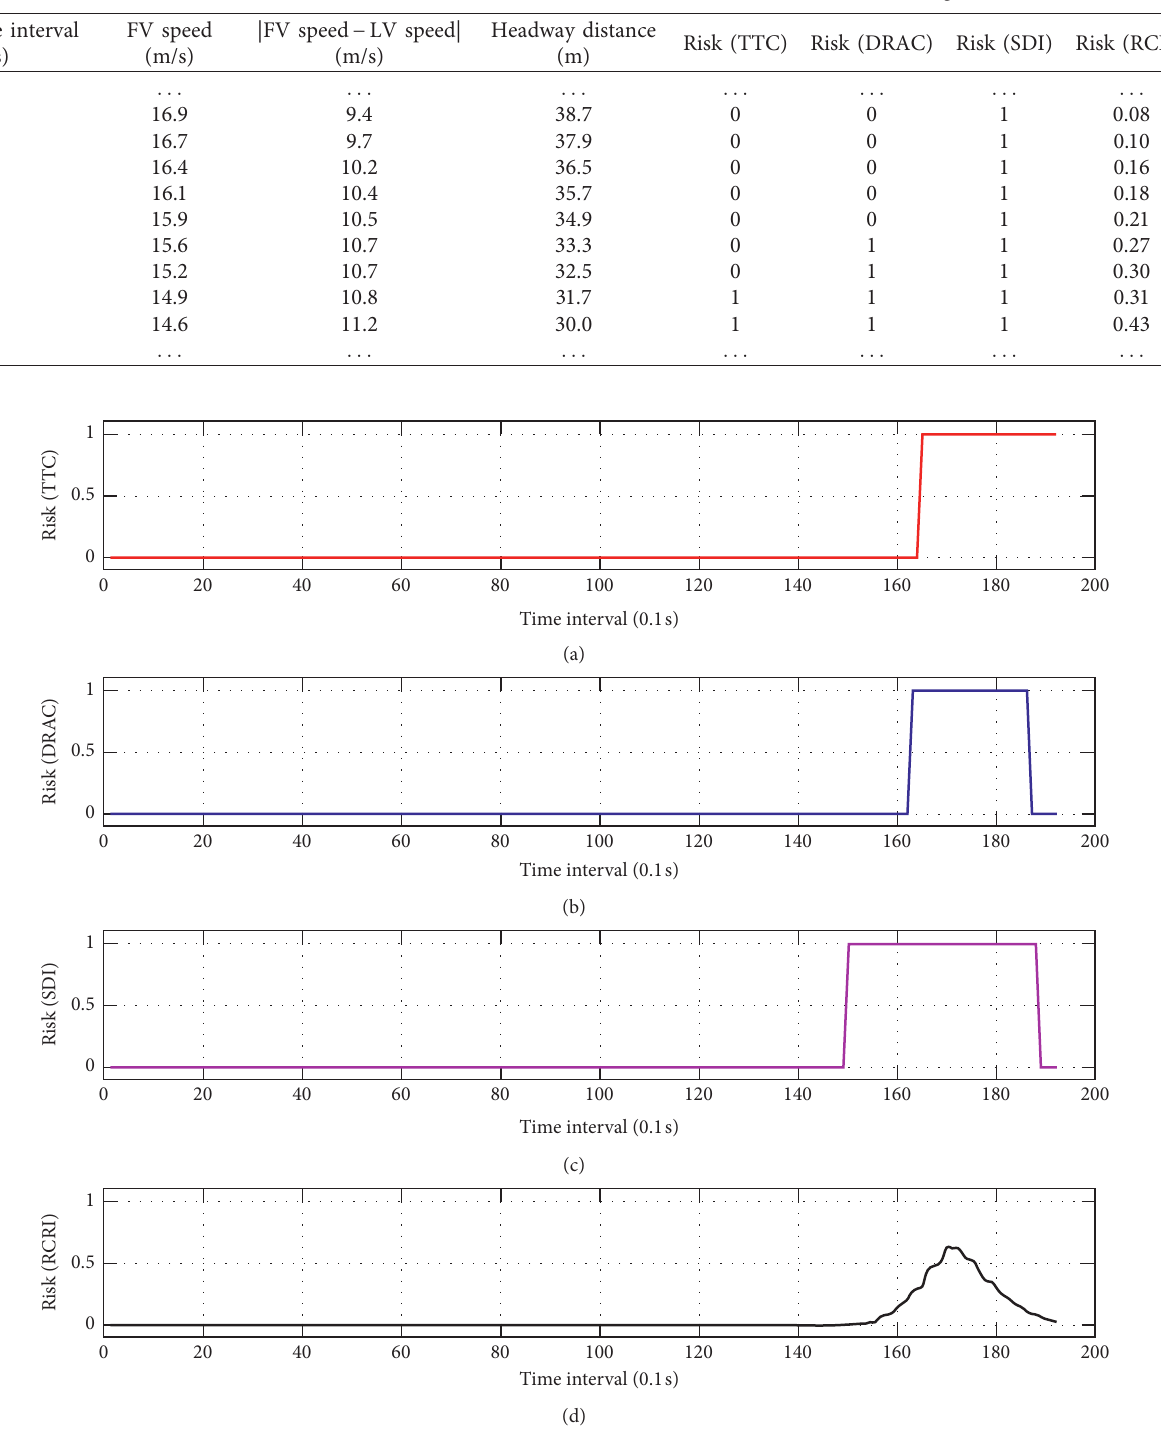
Figure 5: Rear-end crash risk identified by TTC, DRAC, SDI, and RCRI for one car-following